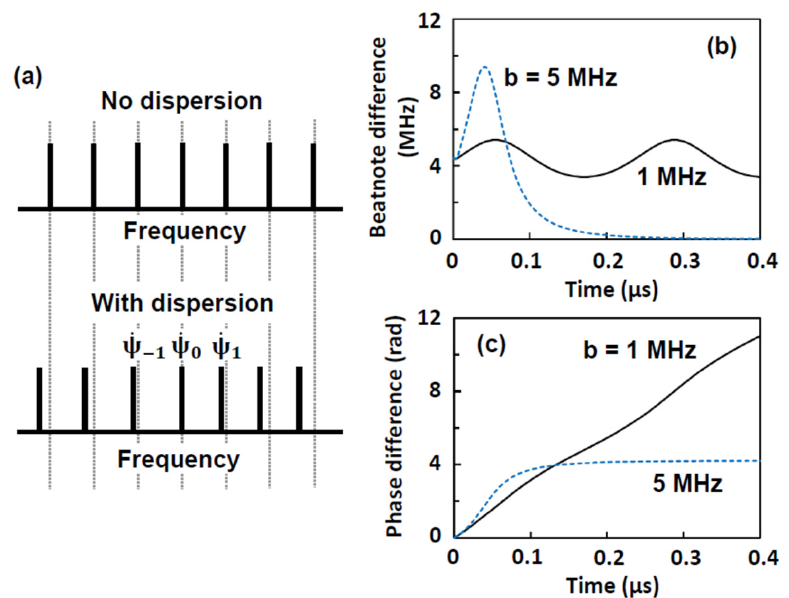
Figure 2. ( a ) Effects of dispersion on the passive cavity modes. Numerical integration of Adler’s equation giving time evolution of ( b ) beat-note difference (cid:3435)𝜓(cid:4662) (cid:2869) − 𝜓(cid:4662) (cid:2868) (cid:3439) − (cid:3435)𝜓(cid:4662) (cid:2868) − 𝜓(cid:4662) (cid:2879)(cid:2869) (cid:3439) and ( c ) corre- sponding phase difference ( ψ 1 − ψ 0 ) − ( ψ 0 − ψ − 1 ) . The parameters are a = 4.4 MHz, b = 1.0 MHz and 5.0 MHz (solid and dashed curves, respectively).